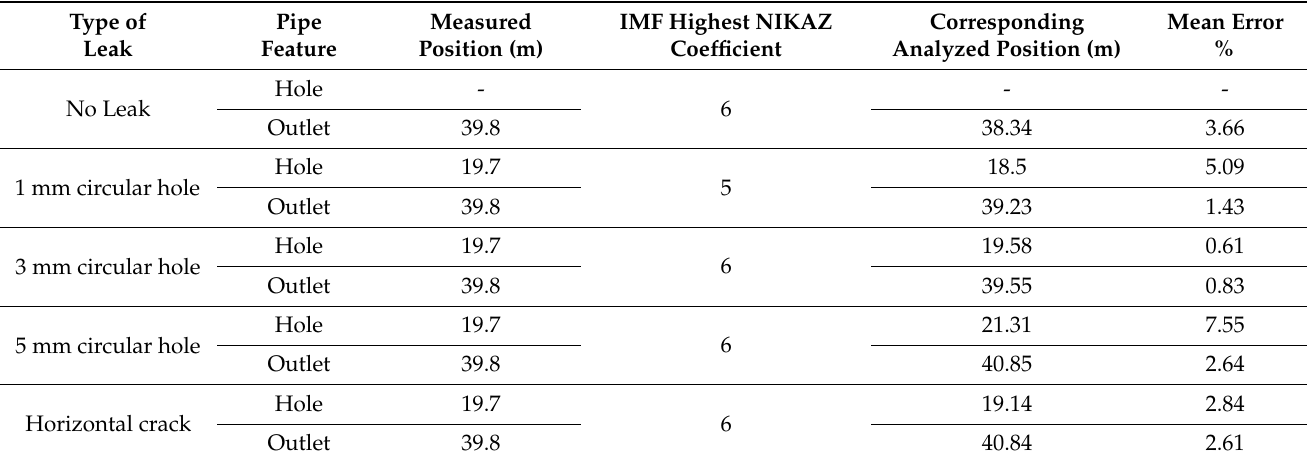
Table 2. NIKAZ evaluation for 2 bar pressurised pipe.